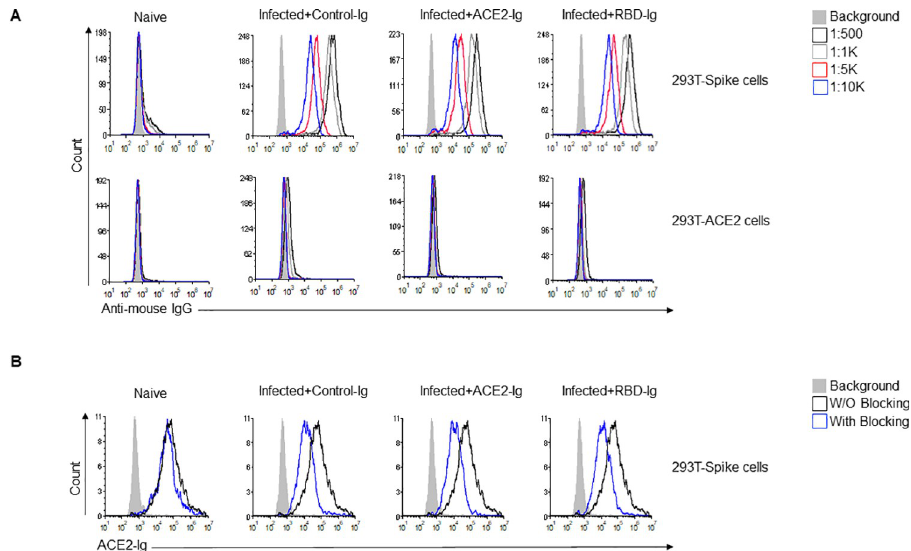
Fig 4. Blocking anti-Spike antibodies are generated in all immunized mice. (A) Anti-Spike IgG antibodies generated by mice following infection with SARS-CoV-2. At 15 DPI mice were bled through the venous tail and sera were obtained from all mice groups and from na ï ve mice and diluted as indicated (upper right). Sera was incubated either with 293T-Spike cells (upper histograms) or with 293T-ACE2 cells (lower histograms) as a primary antibody then cells were stained with Alexa fluor 647 anti-mouse IgG secondary antibody. (B) ACE2-Ig staining of 293T-Spike cells in the presence or absence of sera from the various groups. Sera from all indicated groups were incubated with 293T-Spike cells for 1 hour at 4˚C followed by staining with ACE2-Ig. All histograms were gated on GFP positive cells. Figure shows one representative experiment out of two performed.